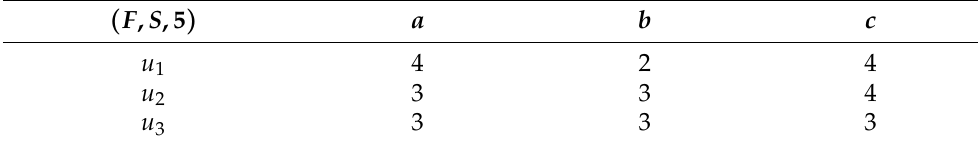
Table 18. The 5-Soft Set of ( F , S ,5 ) . ( F , S , 5 ) a b c u